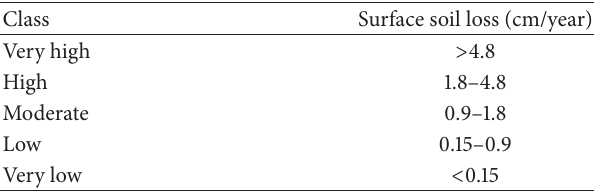
Table 4: Risk assessment of soil erosion in